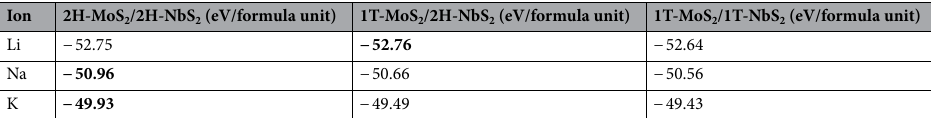
Table 2. Energy of different phases of lithiated 1-MoS 2 /1-NbS 2 heterostructure (with alternating layers of MoS 2 and NbS 2 ) after Li, Na and K intercalation. The numbers in bold identify the lower energy phases of the TMDs in the presence of various intercalating ions.